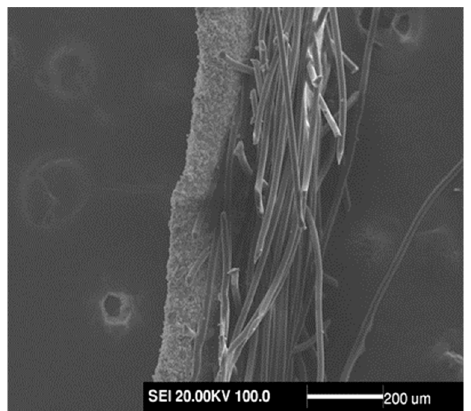
Figure 10. Interface SEM image between hydrophilic layer and hydrophobic layer.